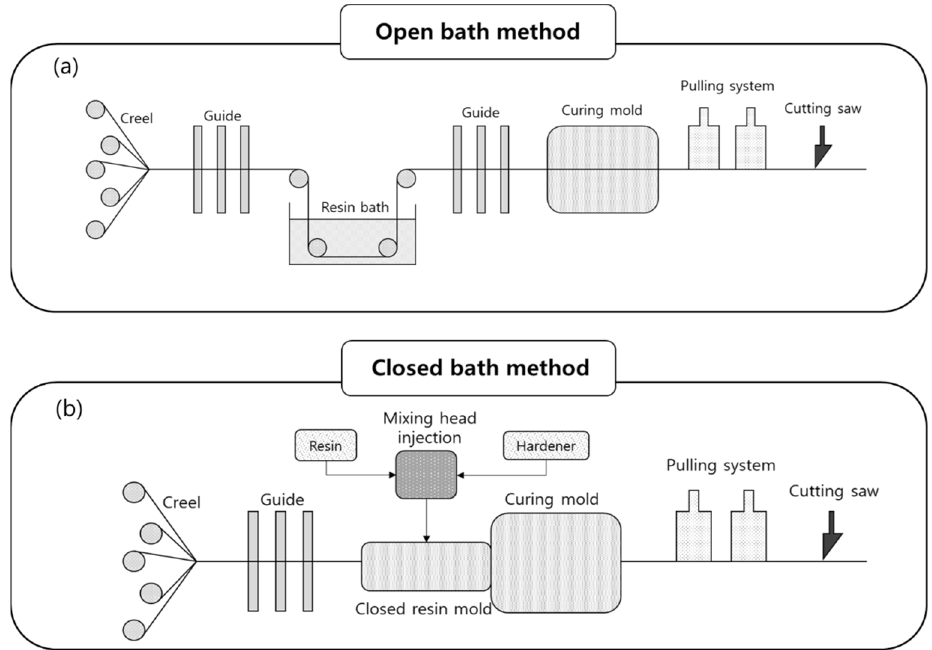
Figure 1. Comparison of ( a ) open bath and ( b ) closed impregnation method.